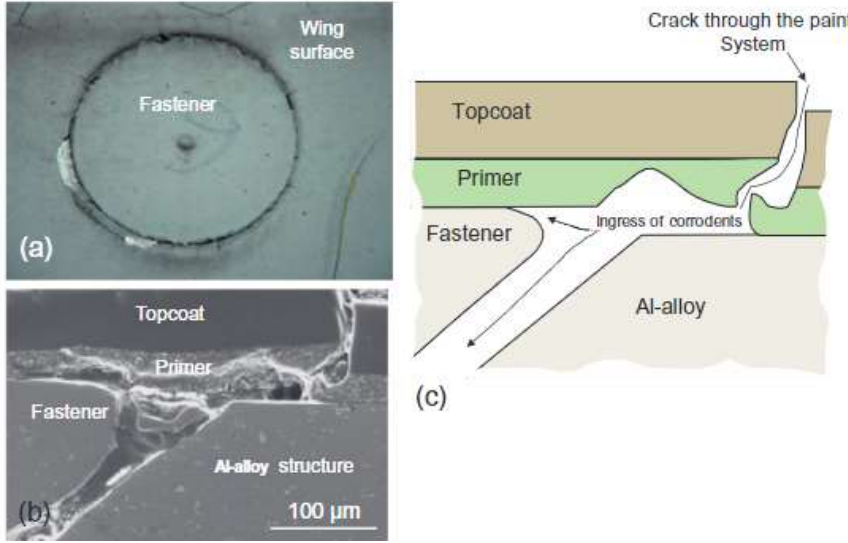
Figure 2. ( a ) Crack in the protective coating around a fastener from an aircraft wing; ( b ) cross-section of the paint coating system, fastener, and metal fixed by the fastener; and ( c ) schematic of ( b ) delineating the path of ingress of corrodents into the fastener cavity. Reprinted with permission from [49] .